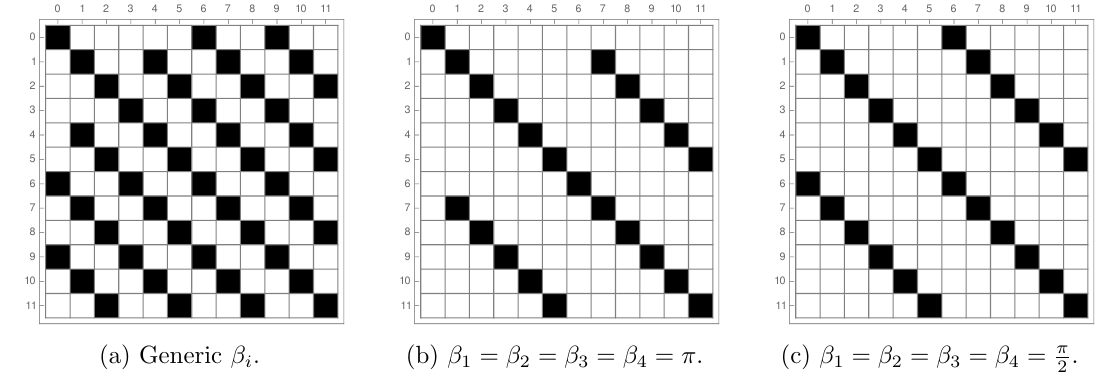
Figure 2. The non-zero products C ( p;p